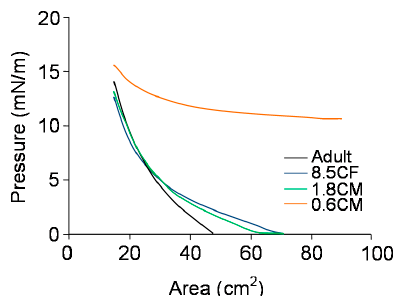
Figure 2. Pressure-area isotherms of meibum films of infants, children, and adults at 35 °C at the air-artificial tear interface.